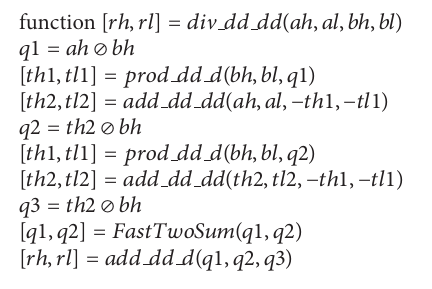
Algorithm 14: Division of a double-double number by a double- double number.